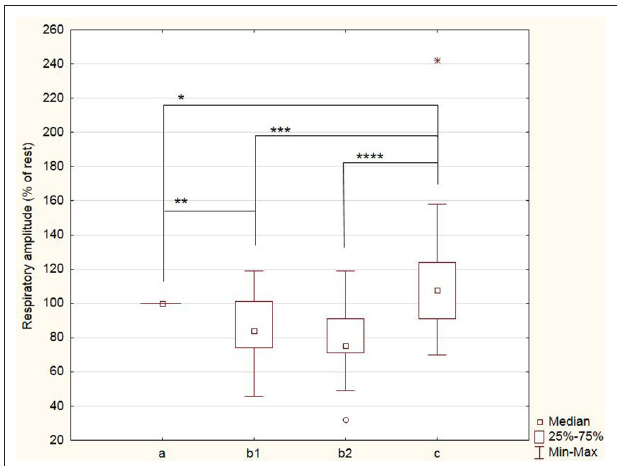
FIGURE 4 | Breathing amplitude during meditation (b1) and (b2) and during control period of paced breathing (c). Amplitude are expressed as percent of rest condition. * p = 0.04; ** p = 0.0006; *** p = 0.0005; **** p = 0.0002.